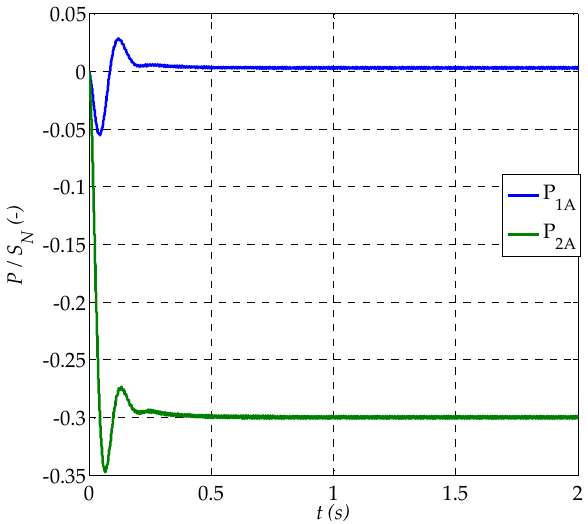
Figure 7. Waveforms of active powers P 1A and P 2A for RL load, p.f. = 0.8.